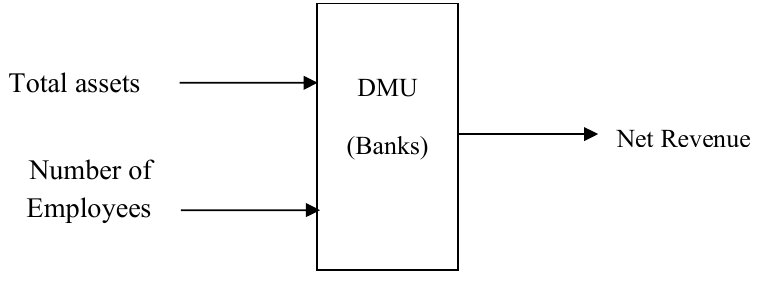
Fig. 1. The input and the output of DEA model